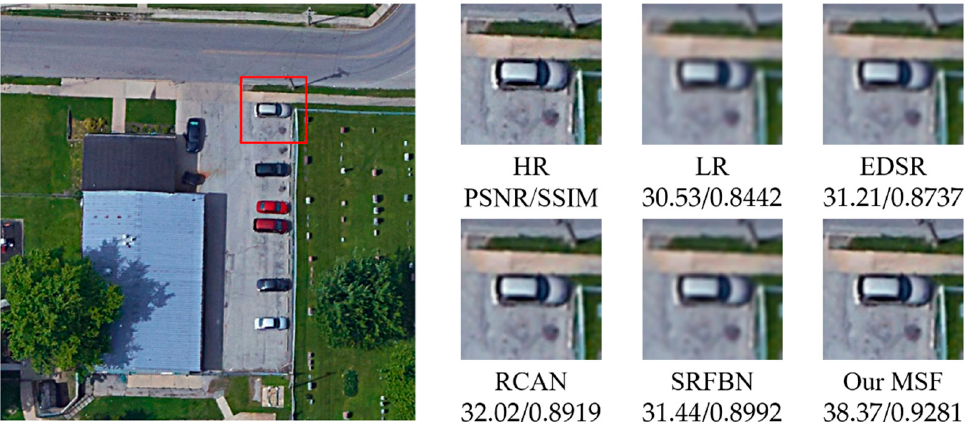
Figure 5. Qualitative comparison between different SR models performance on vehicle instance-class.